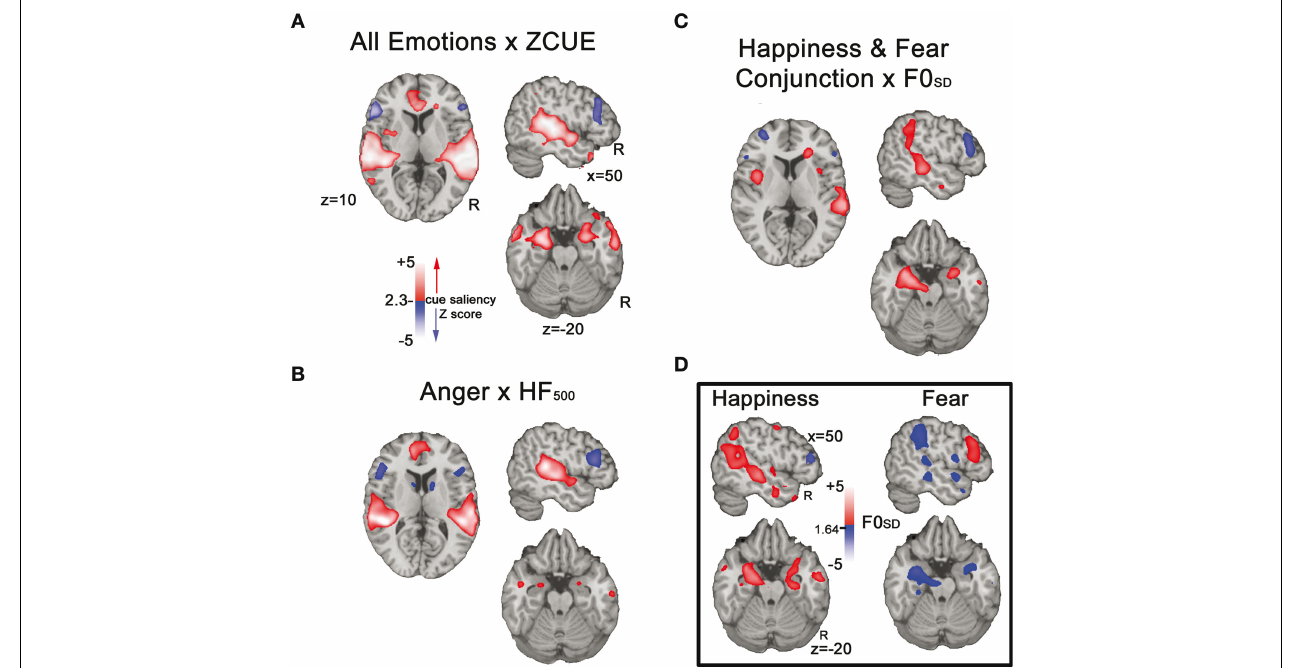
FIGURE 5 | Cue saliency-correlated activation patterns, by emotion. (A) Correlation with a standardized estimate (ZCUE) of cue saliency across all emotions revealed increased PT, pSTG and pMTG activation as cue saliency increased (red), and conversely, increased bilateral IFG activation as cue saliency decreased (blue). (B) A similar pattern was observed for anger as HF decreased. (C) A conjunction analysis of increasing cue saliency (increasing F0 for happy and increasing cue saliency (decreasing F0